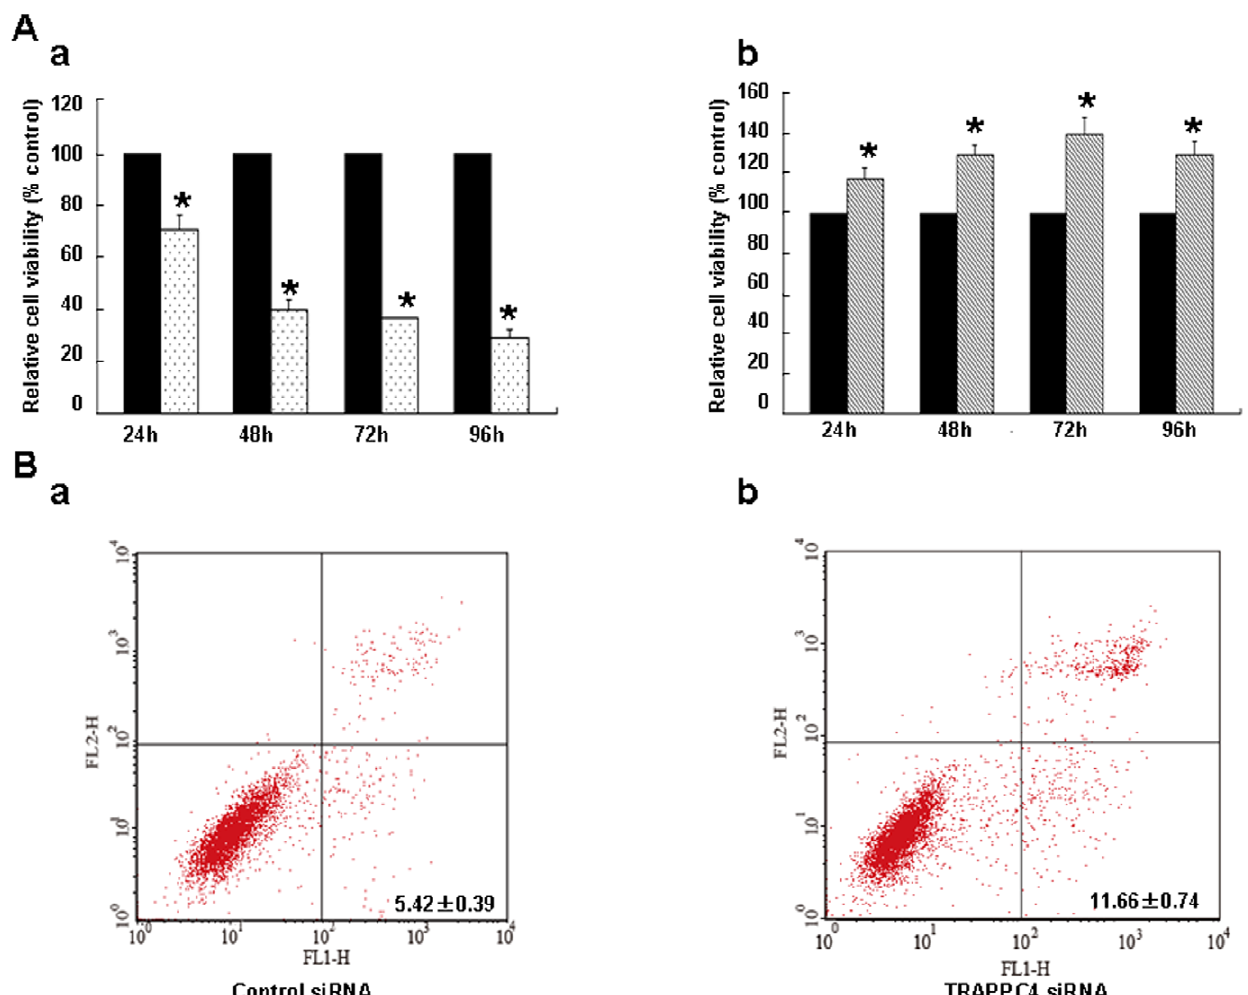
Figure 5. Expression of TRAPPC4 inflenced cell growth and its depletion induced apoptosis on SW1116. A: CCK-8 assay. SW1116 cells were seeded in a 96-well plate until subconfluent. Viable cells were determined by CCK-8 assay. Three independent time were performed in triplicate. Cells were treated with TRAPPC4 siRNA to knockdown TRAPPC4 expression or with Negtive Control siRNA used as control (a), as well as tranfered with pCDEF-myc-TRAPPC4 vector to overexpress TRAPPC4 protein or with pCDEF-myc vector as control (b). *, p , 0.05. B: Apoptosis analysis. After SW1116 cells were treated with TRAPPC4 siRNA or Negtive Control siRNA used as control for 48 h. Apoptosis was carried out using the Annexin V assay with Propidium iodide counterstaining allowing quantification by flow cytometry. Three independent time were performed in triplicate. The data were presented as means 6 standard deviation (SD). There was significant difference between the two groups( p ,